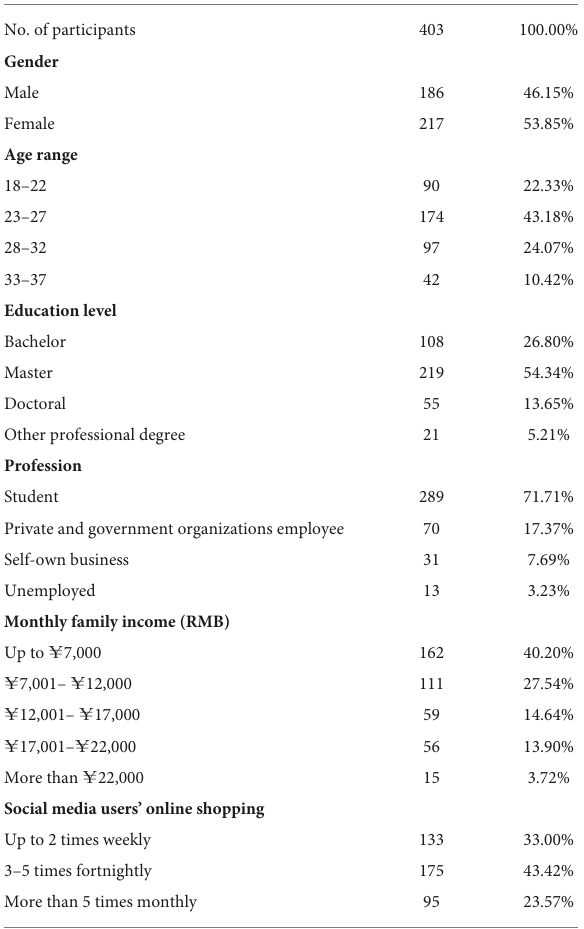
TABLE 1 Targeted audience